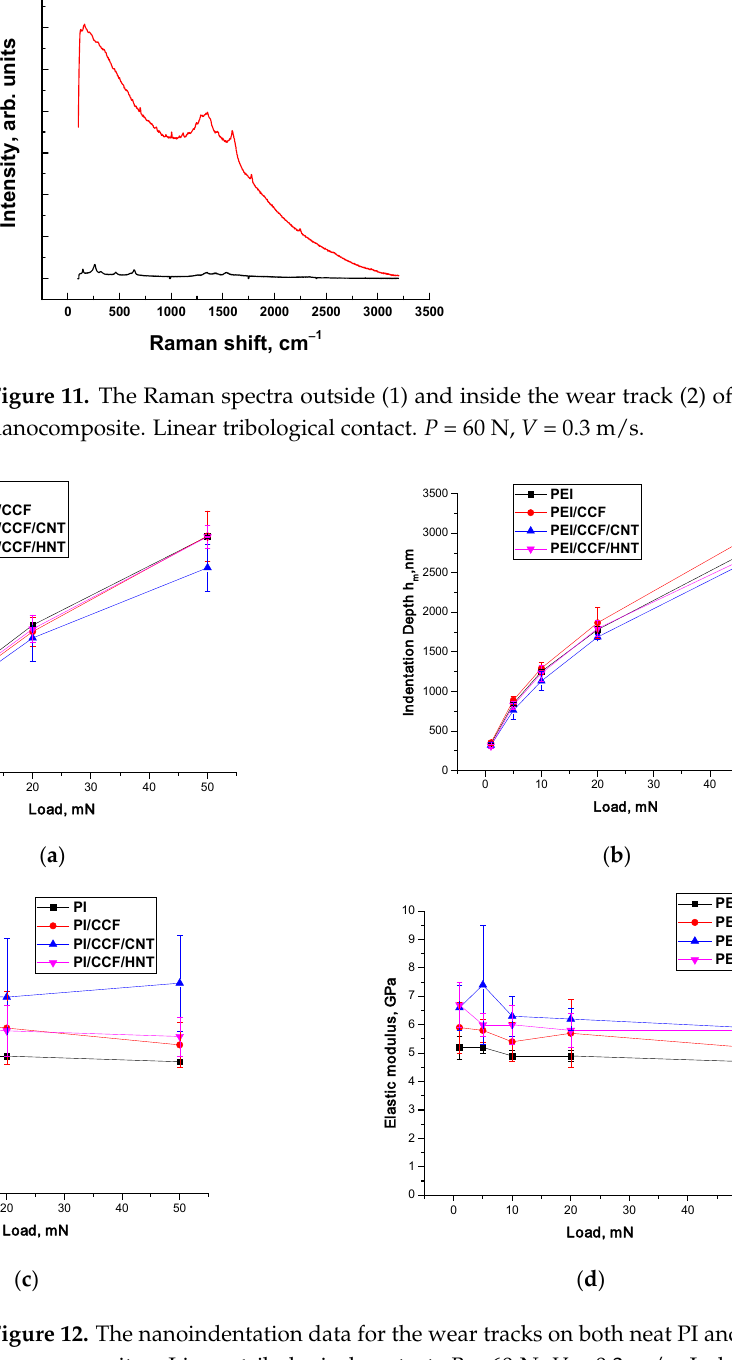
( d ) Figure 13. SEM micrographs of the wear track surfaces on the PI/10CCF/1CNT ( a ), PI/10CCF/1HNT ( b ), PEI/10CCF/1CNT ( c ) and PEI/10CCF/1HNT ( d ) nanocomposites. Digits in blue squares denote Spectra numbers in Table 6.